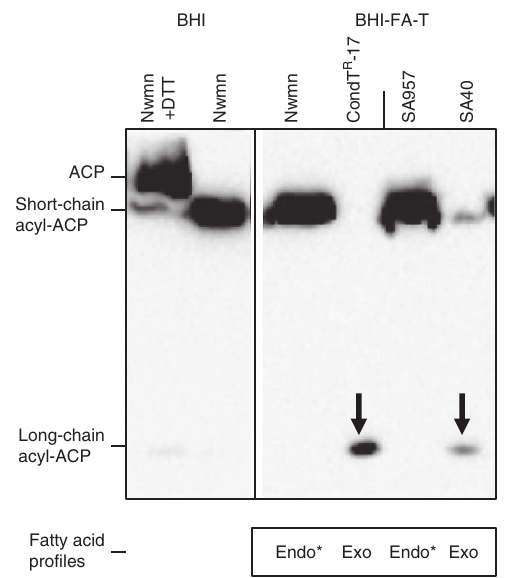
Figure 7 | Shift in ACP species in strains with fabD 196 polymorphisms. The impact of an altered amino acid at FabD position 196 on acyl-ACP pools was tested by comparing strain pairs: Newman and CondT R -17 (G196 and R196 respectively), and the ST59 pair SA957 (virulent) and SA40 (nasal isolate) 45 (G196 and S196 respectively). Extracts prepared from 4h cultures in BHI-FA-T medium were run on conformation-sensitive gels. Anti-ACP antibodies were used to identify ACP moieties after gel transfer. In these gels, migration of acyl-ACP species increases with longer acyl chain length 46,66 . DTT treatment reduces acyl-ACP thioesters and releases free ACP 47 ; the DTT-treated Newman protein extract from BHI-grown cells was used as migration control. Short-chain acyl-ACP is predominant in reference strains, and long-chain acyl-ACP moieties (arrows) are detected only in extracts of fabD variants. Results of fatty acid profiles of reference strains and fabD variants are indicated below respective lanes. Nwmn, Newman strain; *, fatty acid profiles derived from non-growing cultures. The Western is from a single gel with the same exposure, and results are representative of 3 biologically independent experiments. The Western blot shown above corresponds to the entire gel. enzymes at opposing ends of the pathway: the FASII initiation enzyme FabD (which uses ACP to synthesize malonyl-ACP) and the post-FASII termination enzyme PlsX (which catalyses the reversible formation of acyl-phosphate from acyl-ACP) 43,50 . Lower FabD activity would leave more ACP available for